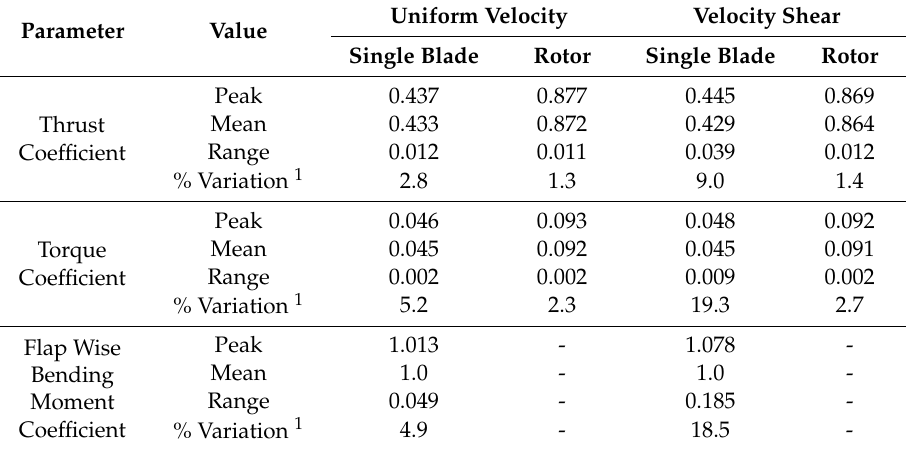
Figure 8. Variation of torque coe ffi cient C θ for Blade 1 during two rotation cycles.